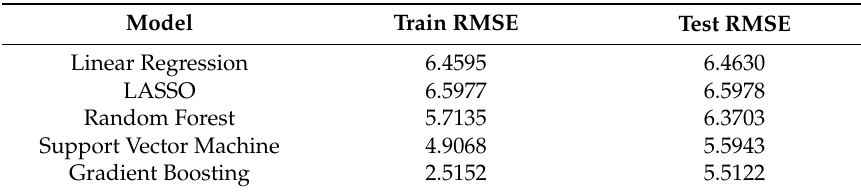
Table 5. Train and test RMSE of di ff erent models.